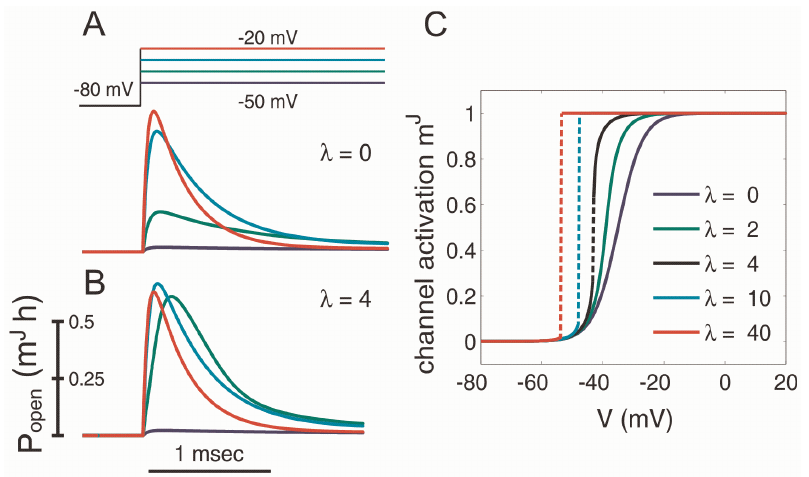
Figure 2. Dependence of the sodium channel dynamics on the coupling strength l ( k A ~ 4, V 1 = 2 ~{ 35 mV ). ( A,B ) Simulated open probability of sodium channels in response to steps of holding potential of increasing amplitude. The voltage-clamp protocol is shown above the traces in ( A ). Simulations for independent channels ( A , l ~ 0 ) and for cooperative channels with the critical value of coupling strength l (cid:1) ( B , l ~ 4 ). ( C ) Collective activation curves of sodium channels with an increasing coupling strength l . Discontinuous portions of activation curves for l § 4 are shown as interrupted lines.